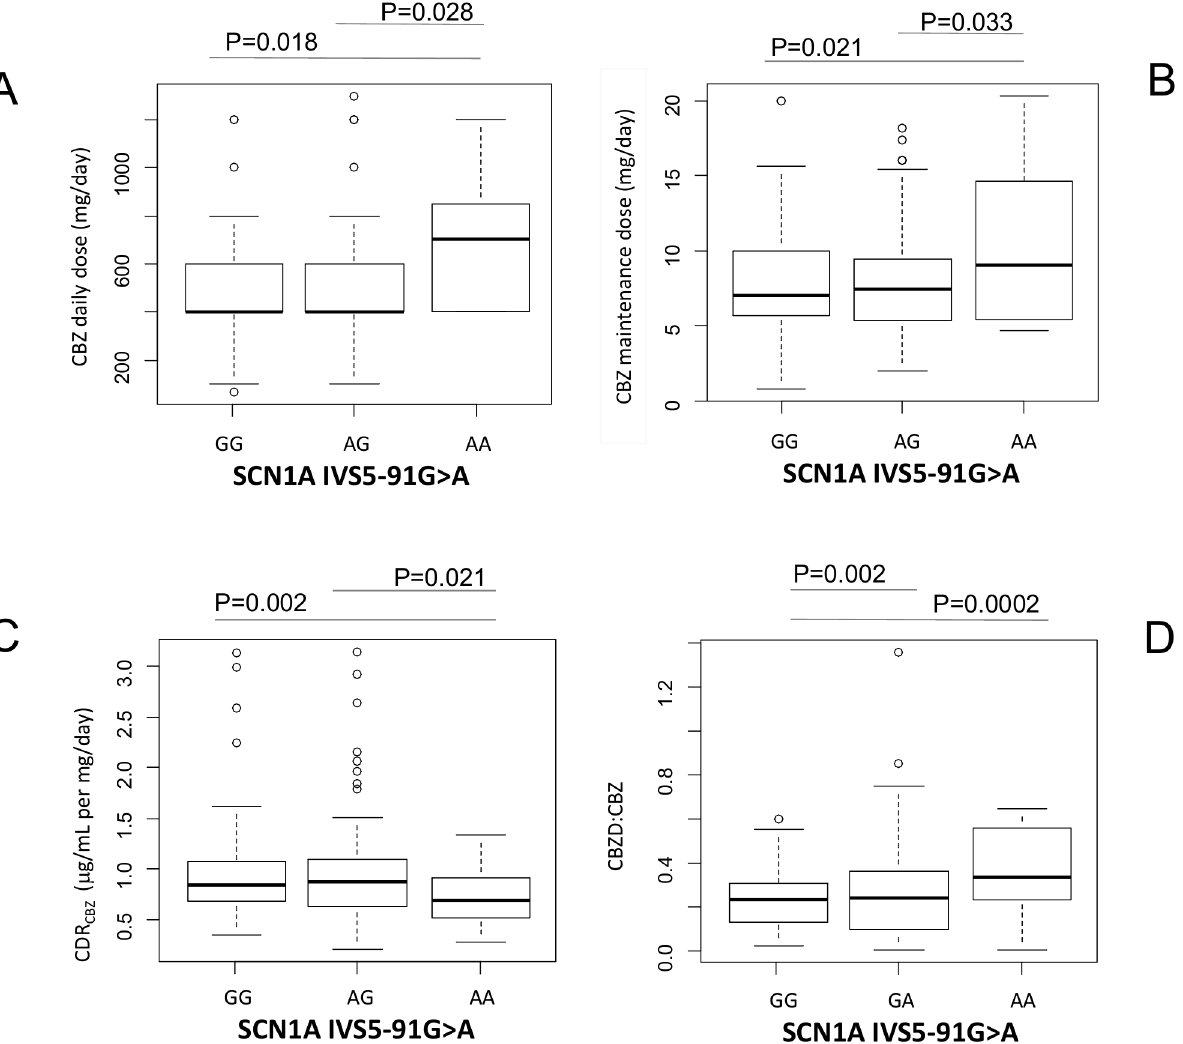
Fig 3. Graphical representations (box-plot) of the sodium channels (SCN1A IVS5-91 G > A) SNPs genotypes associations with (A) CBZ daily dosage (mg/day), (B) CBZ maintenance dose (mg/kg per day), (C) CDR CBZ and (D) CBZD:CBZ. Statistical significance for difference of means is shown (P values, one way ANOVA analysis followed by Student ’ s